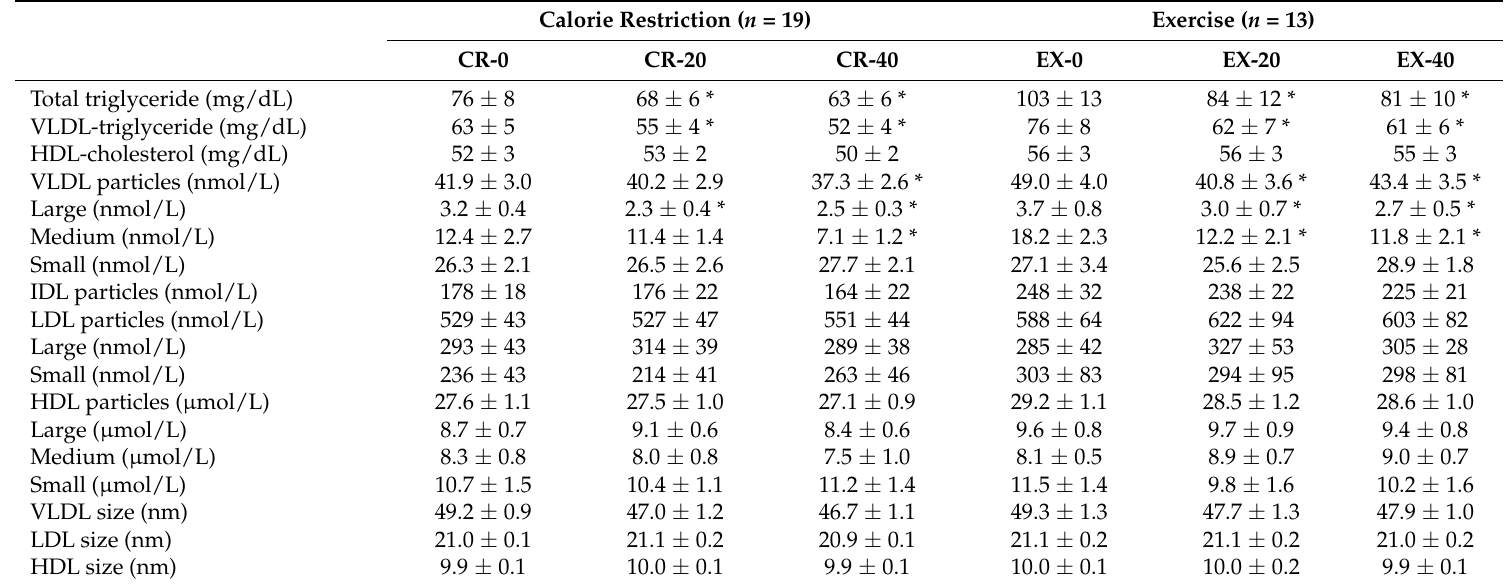
Table 2. Effects of diet- and exercise-induced energy deficits on lipoprotein concentrations, subclasses, and particle